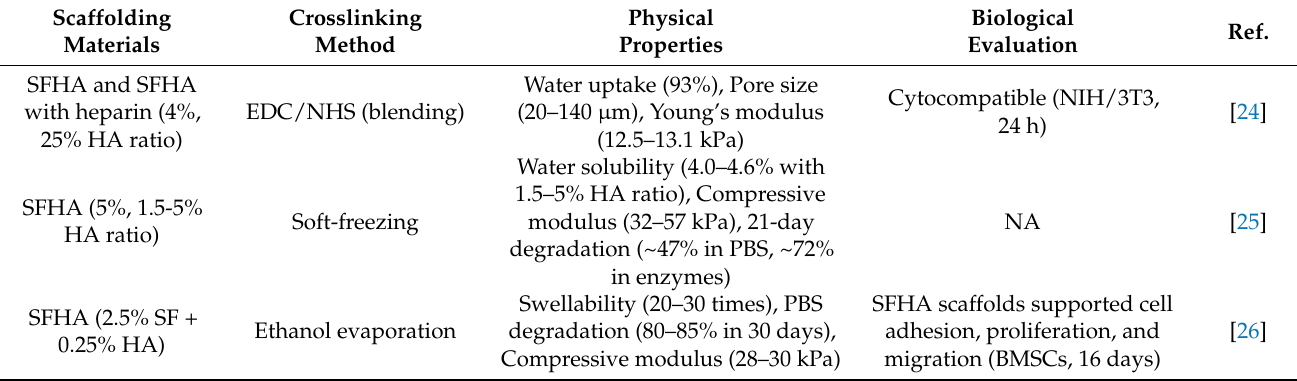
Table 2. Comparison of the scaffolds fabricated from SF, G and HA (NA = data not available, BMSCs = bone